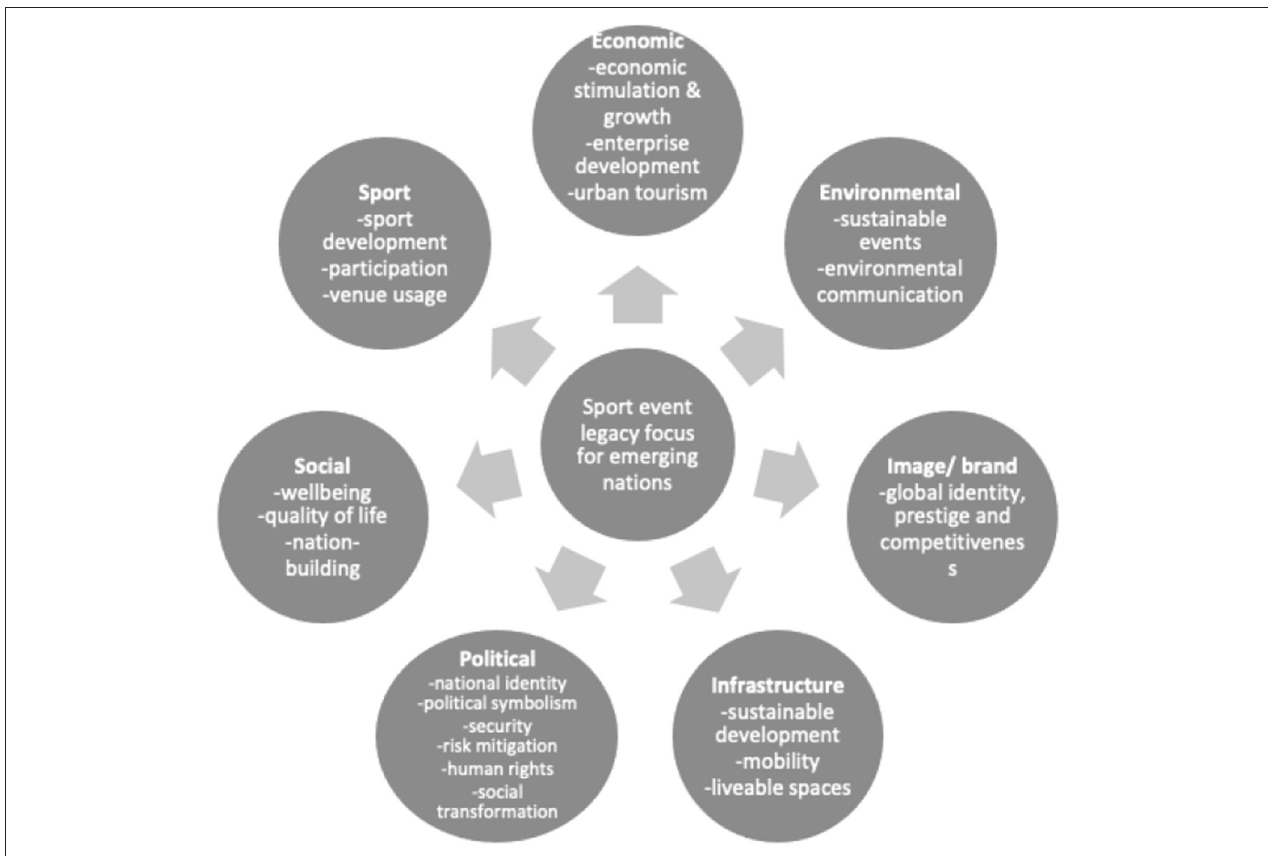
FIGURE 5 | Legacy focus for emerging